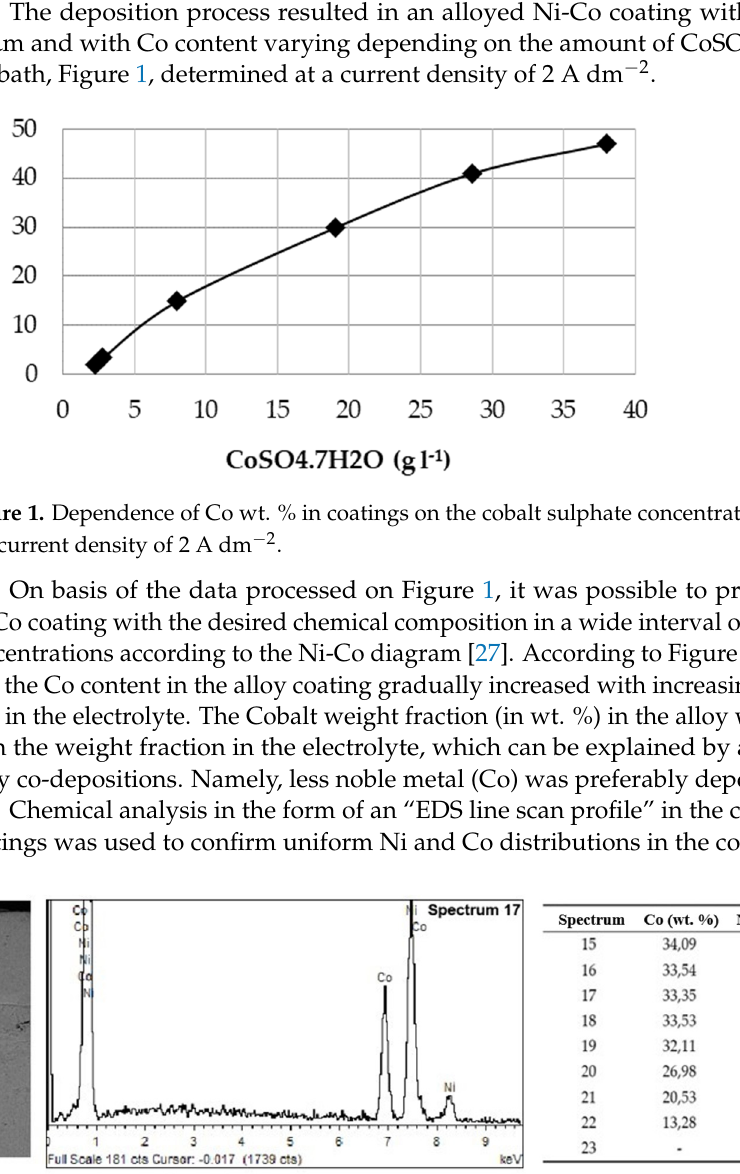
Figure 2. SEM images and EDS analysis of Ni-Co coating with 31.80 wt. % Co deposited at 2 A dm − 2 .